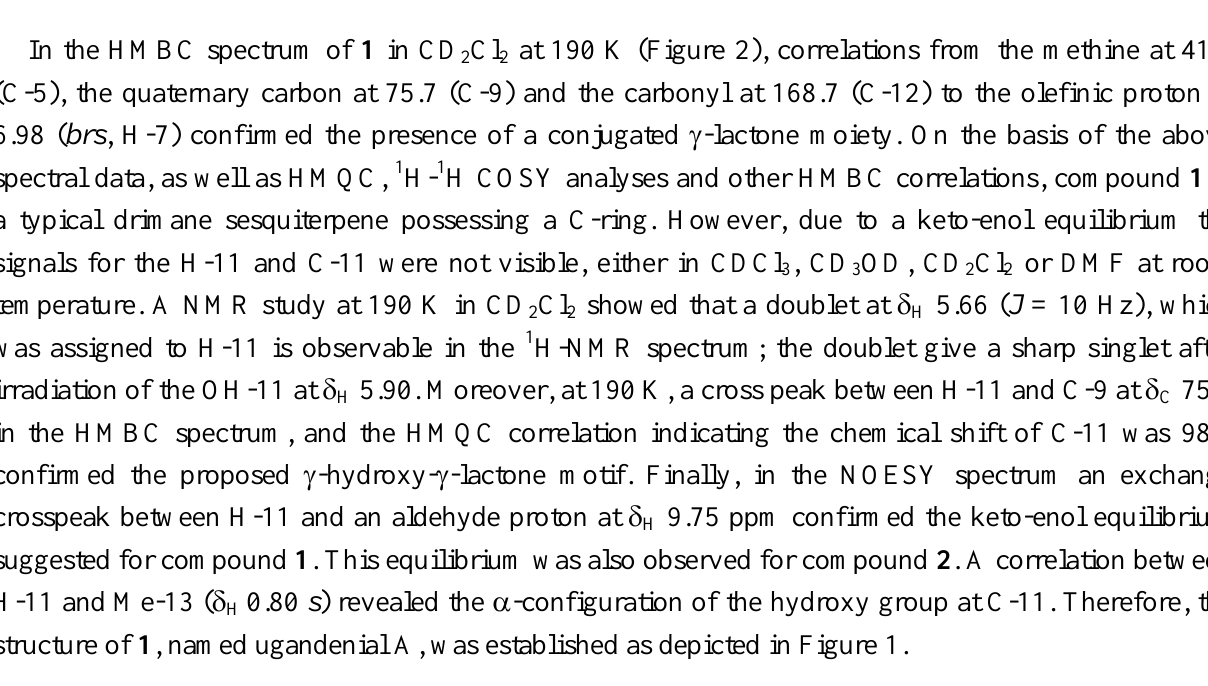
Figure 2. Key HMBC and NOESY interactions for compound 1